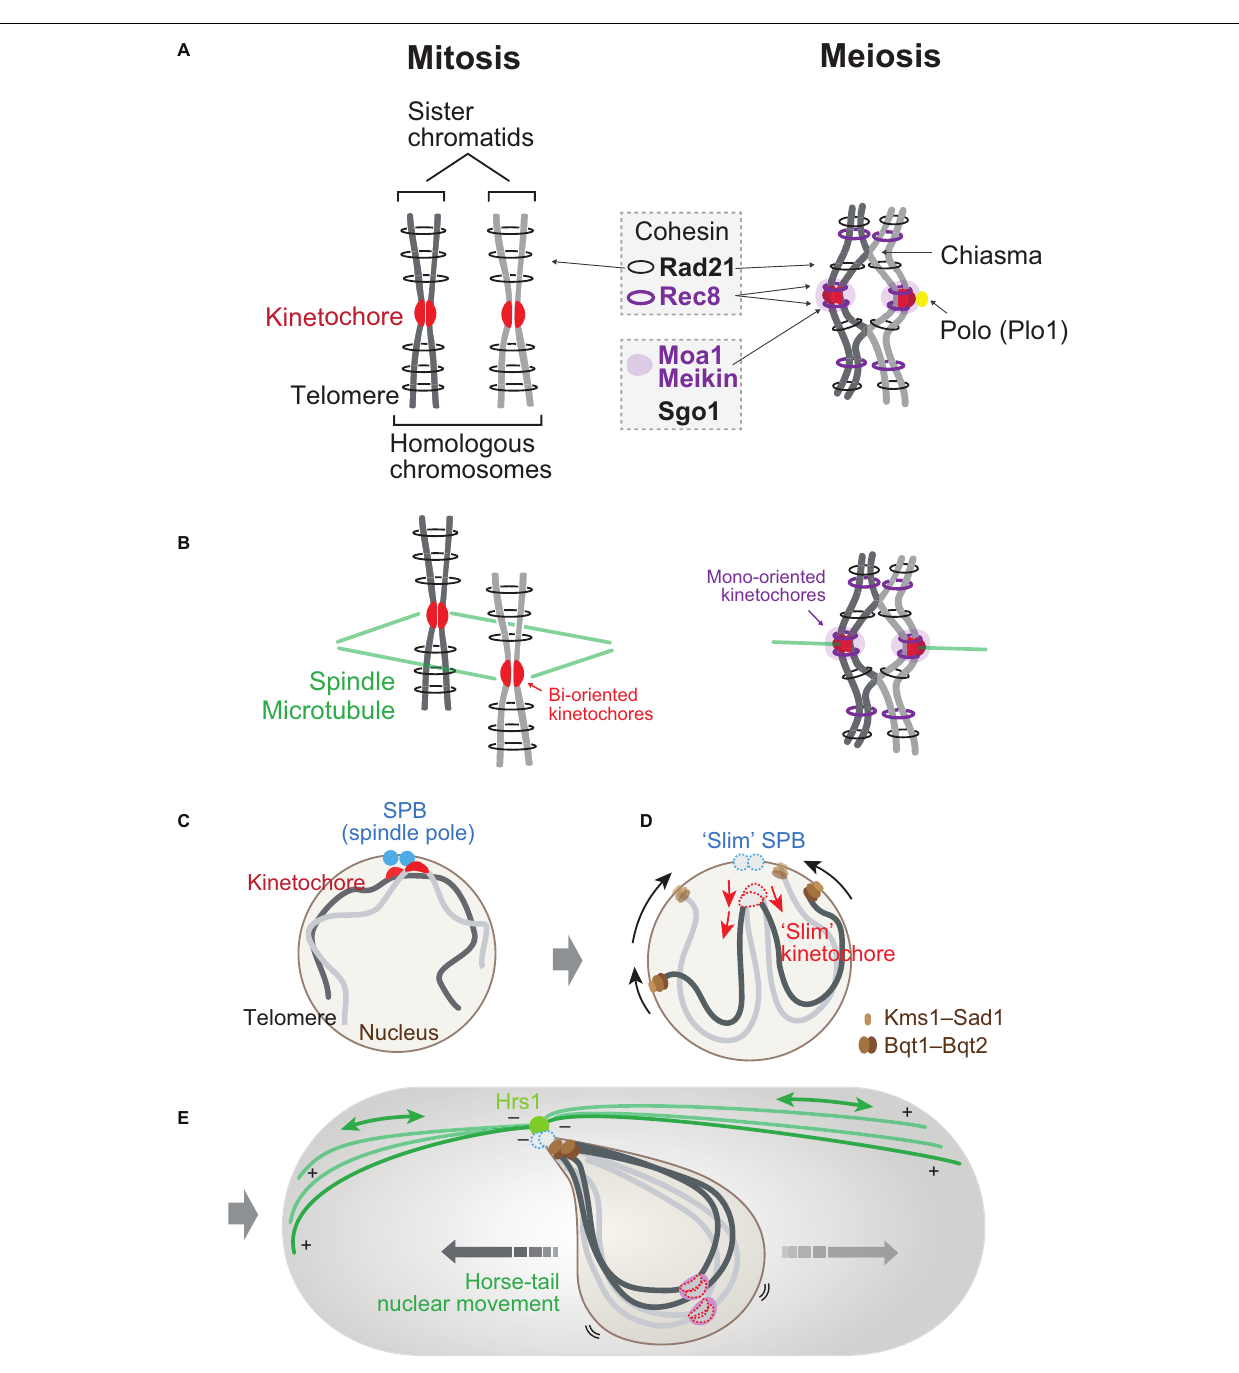
Frontiers in Cell and Developmental Biology | www.frontiersin.org